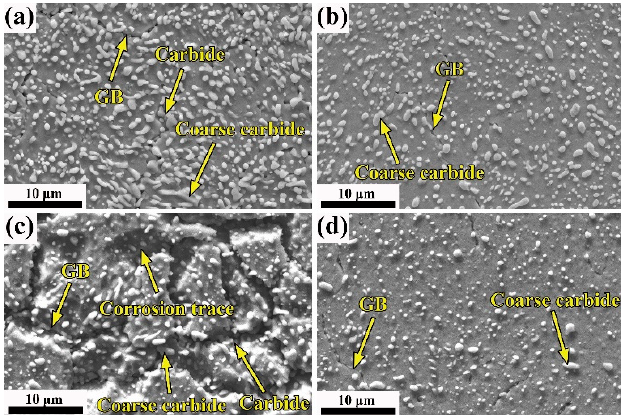
Figure 4. SEM images of the DFZ and LFZ in hot-rolled bearing steel: ( a ) the DFZ etched for 3 min; ( b ) the LFZ etched for 3 min; ( c ) the DFZ etched for 6 min; ( d ) the LFZ etched for 6 min. The diameters of the carbides in the DFZ and LFZ were measured, as shown in